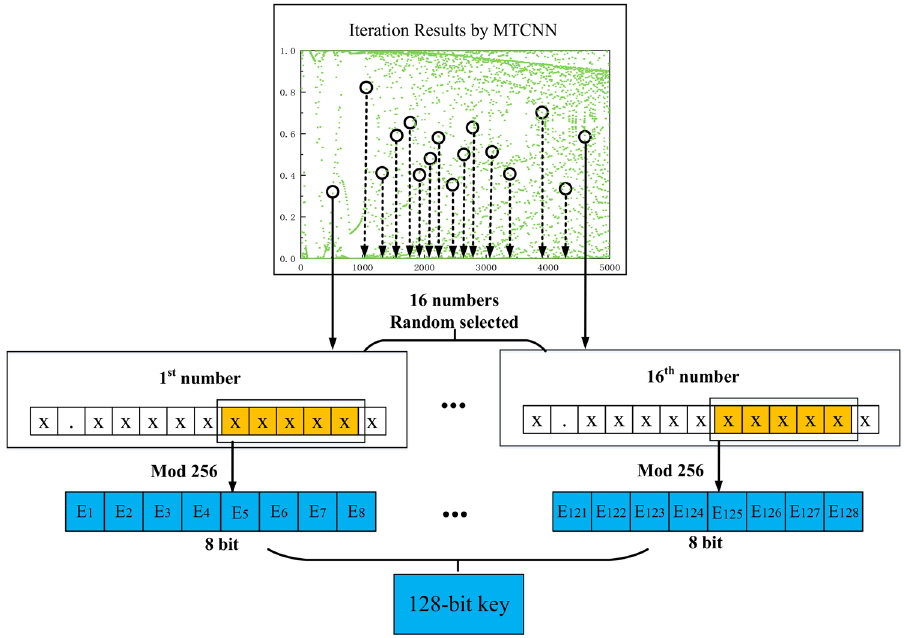
Figure 3. Schematic diagram of the 128-bit key generation by